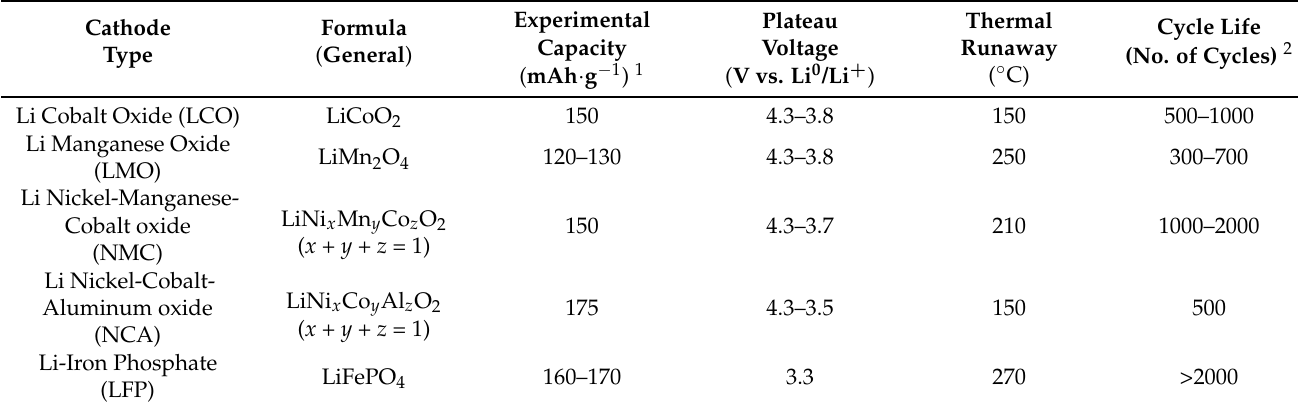
Table 1. Experimental capacity, plateau voltage, thermal runaway temperature, and cycle life for different cathodes (reference values [30]).